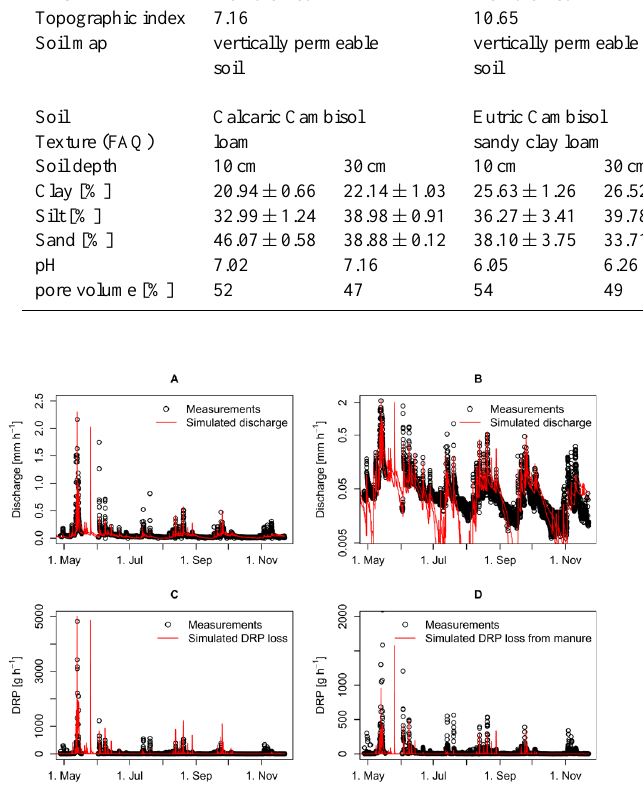
Fig. 3. Simulations (lines, 10% and 90% quantiles) using RRP Ver- sion 2 versus measured (points) discharge and DRP loss from the Stägbach catchment in